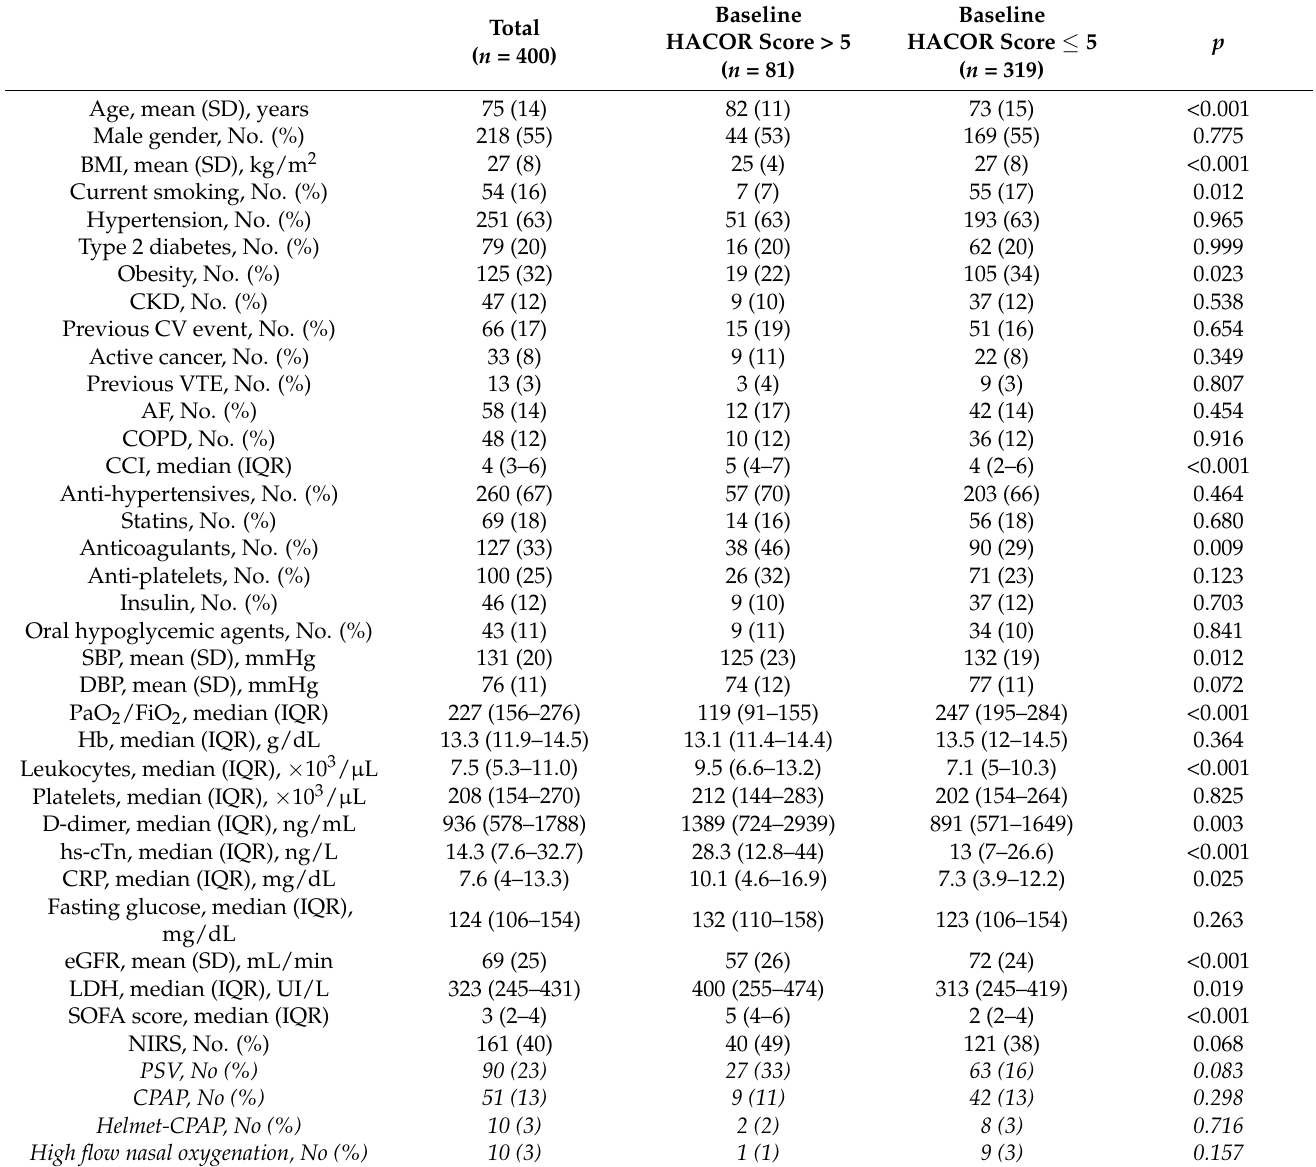
Table 2. Characteristics of the study